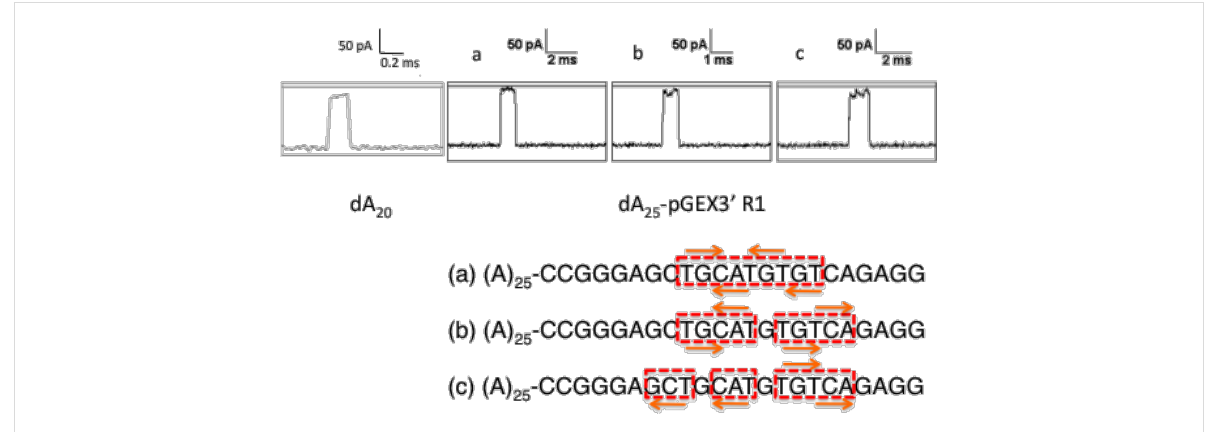
Figure 7: Sample I – t traces for the control dA 20 and for dA 25 -pGEX3’ R1 (with 4T(OsBp)) to show (a) continuous blockage, (b) blockage interrupted once, or (c) blockage interrupted twice. These inter-events steps may be attributed to selected configurations (a to c) as above. Theoretically three interruptions of blockages are expected for 4 modifications. Arrows indicate OsBp moiety and have direction; red blocks indicate partial coverage of adjacent bases due to the presence of OsBp. The planar structure of OsBp prohibits full coverage of adjacent bases (not shown in the 2D